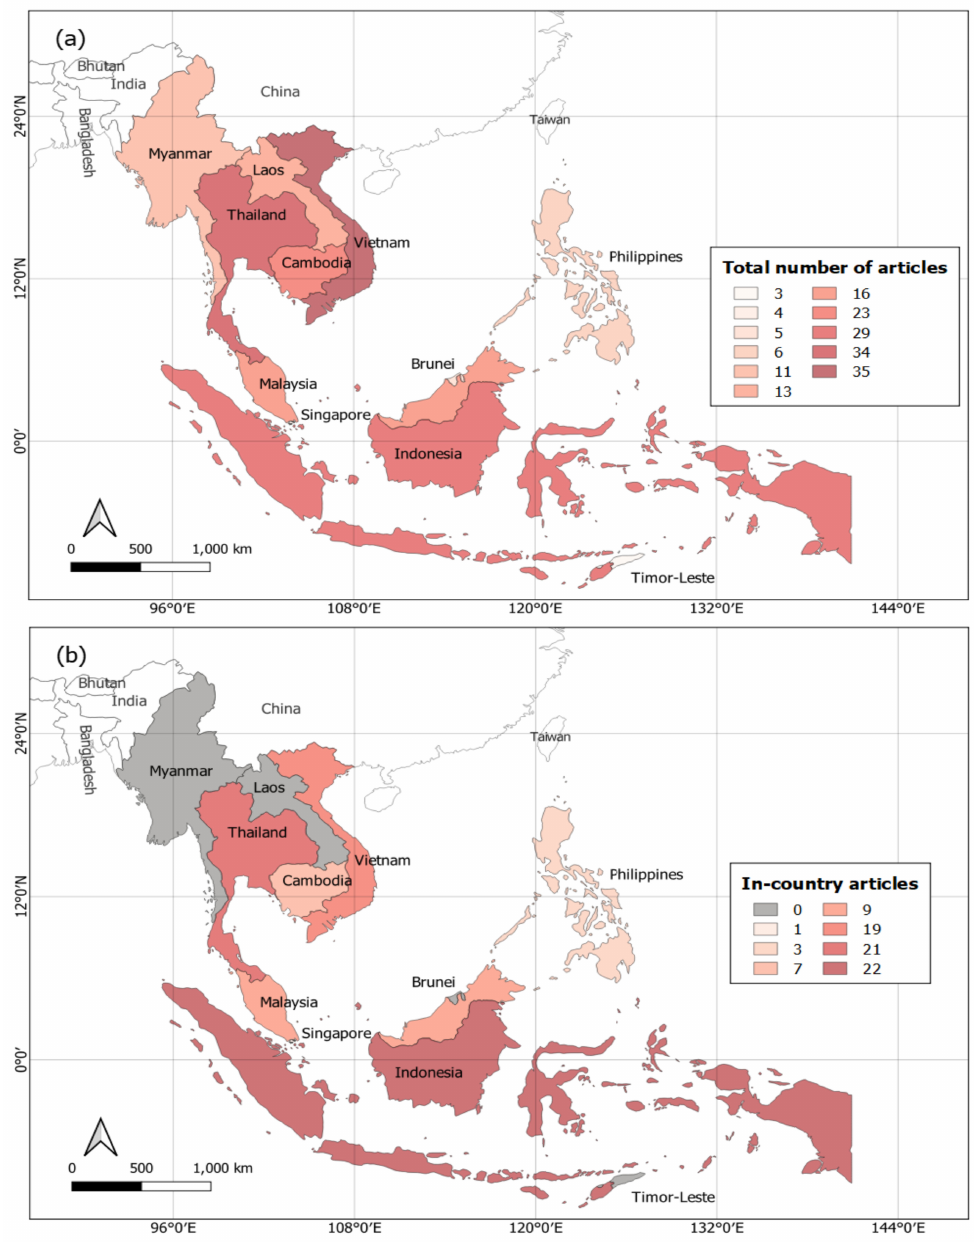
Figure 5. The map shows the spatial distribution of drought publications in Southeast Asian coun- tries. The color codes indicate the total number of reported drought articles, including local and transboundary studies ( a ) and the number of reported local and national drought publications ( b ). The maps used in this figure were obtained from GADM (https://gadm.ogr, last accessed on 25 February